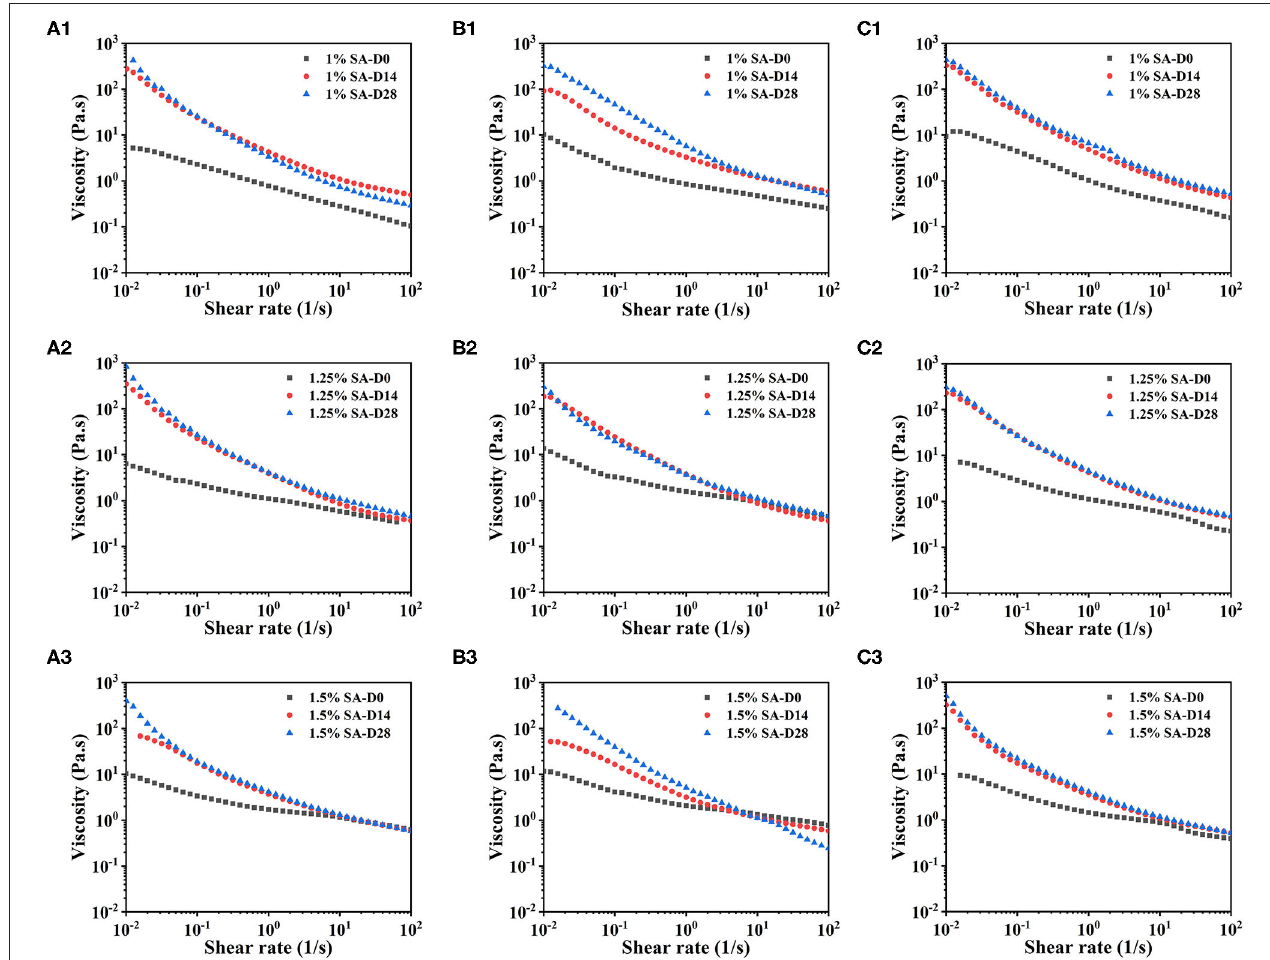
FIGURE 5 | Steady-state shear sweep images: E1 emulsion with 1% SA (A1) , 1.25% SA (A2) , and 1.5% SA (A3) , E2 emulsion with 1% SA (B1) , 1.25% SA (B2) , and 1.5% SA (B3) , E3 emulsion with 1% SA (C1) , 1.25% SA (C2) , and 1.5% SA (C3) . D0, D14 and D28 represent emulsions stored for 0, 14 and 28